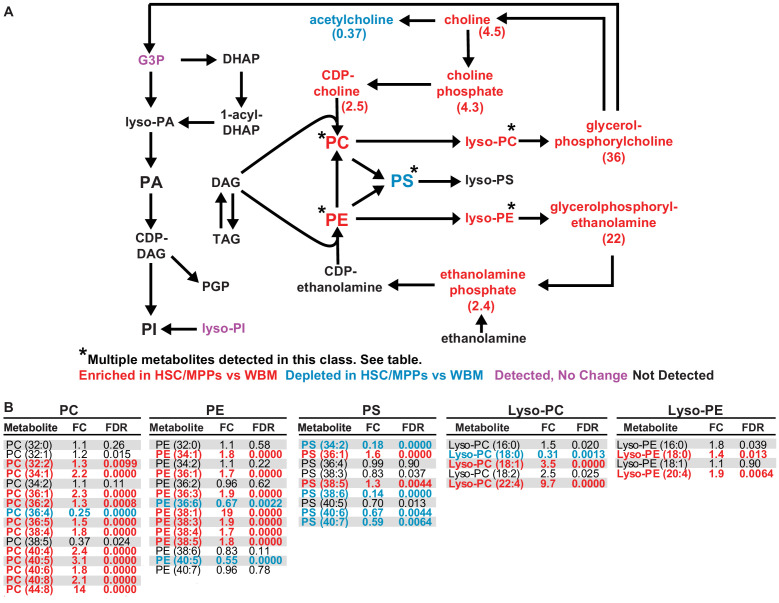
Glycerophospholipids are enriched in hematopoietic stem cell (HSC)/multipotent progenitors (MPPs) as compared to whole bone marrow (WBM) cells.(A) Schematic of glycerophospholipid metabolism and (B) list of phosphatidylcholines (PC), phosphatidylethanolamines (PE), phosphatidylserines (PS), Lyso-PCs, and Lyso-PEs detected in 10,000 HSCs/MPPs or WBM cells by our method. Red metabolites were enriched in HSC/MPPs and blue metabolites were depleted in HSC/MPPs. Purple metabolites were detected but not significantly changed. Black metabolites were not detected (n = 11 replicates per cell population from a total of four independent experiments).